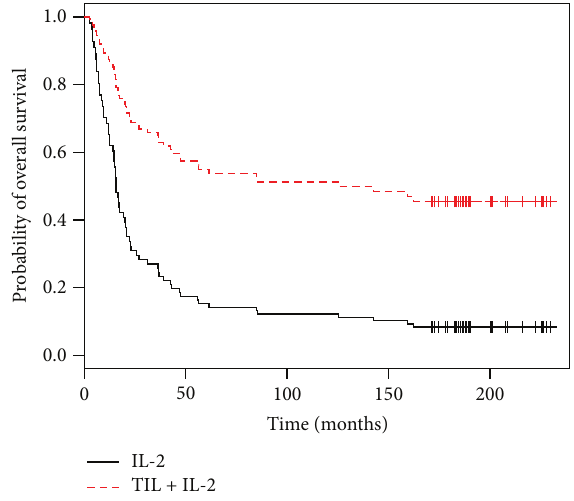
Figure 4: Cox survival curves when only one node is invaded, the Breslow is ≥ 1.5, and a capsular breaking is present.